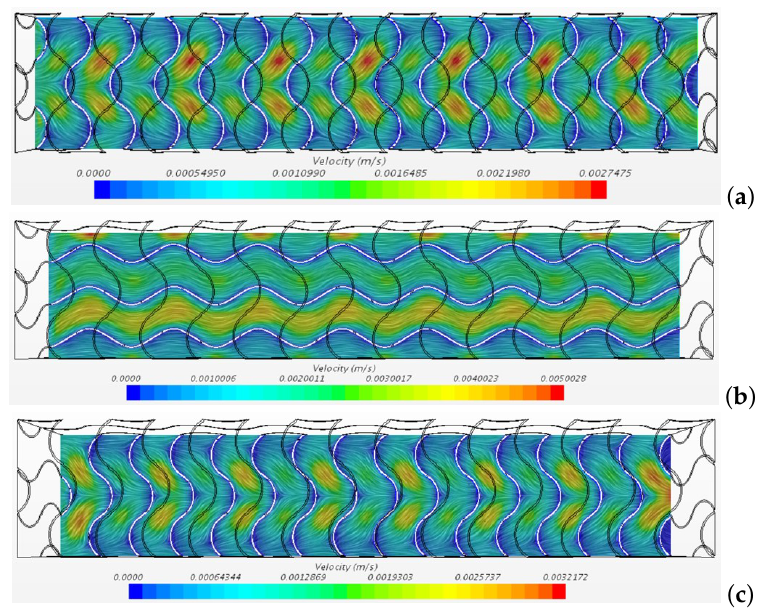
Figure 5. Streamlines for the case Re = 3.6 on three planes y / H = 1/3 ( a ) y / H = 1/2 ( b ) and y / H = 2/3 ( c ).